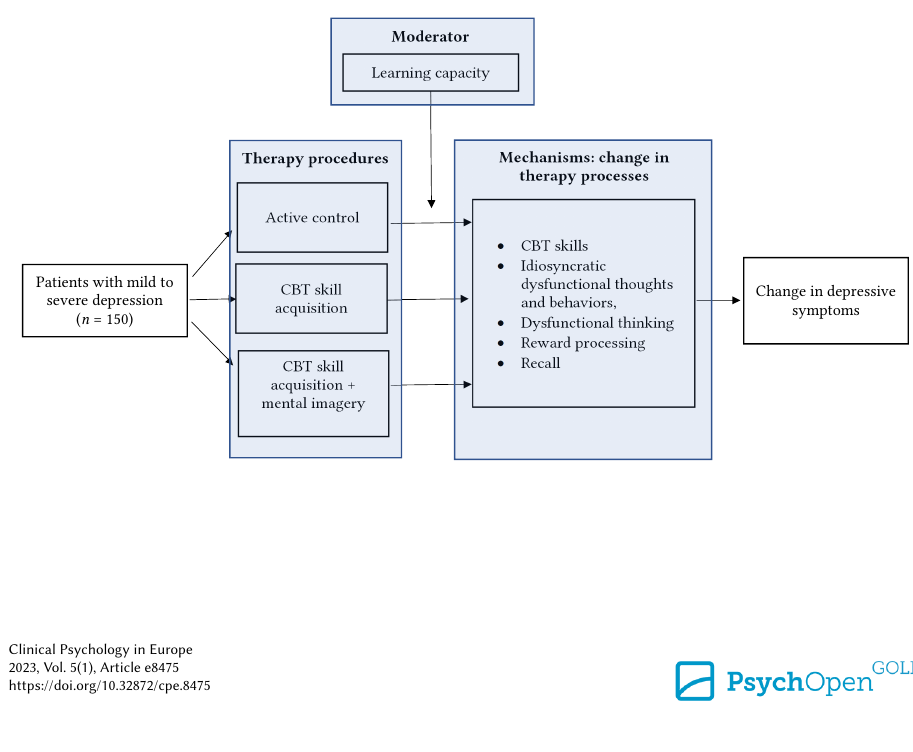
Moderator Learning